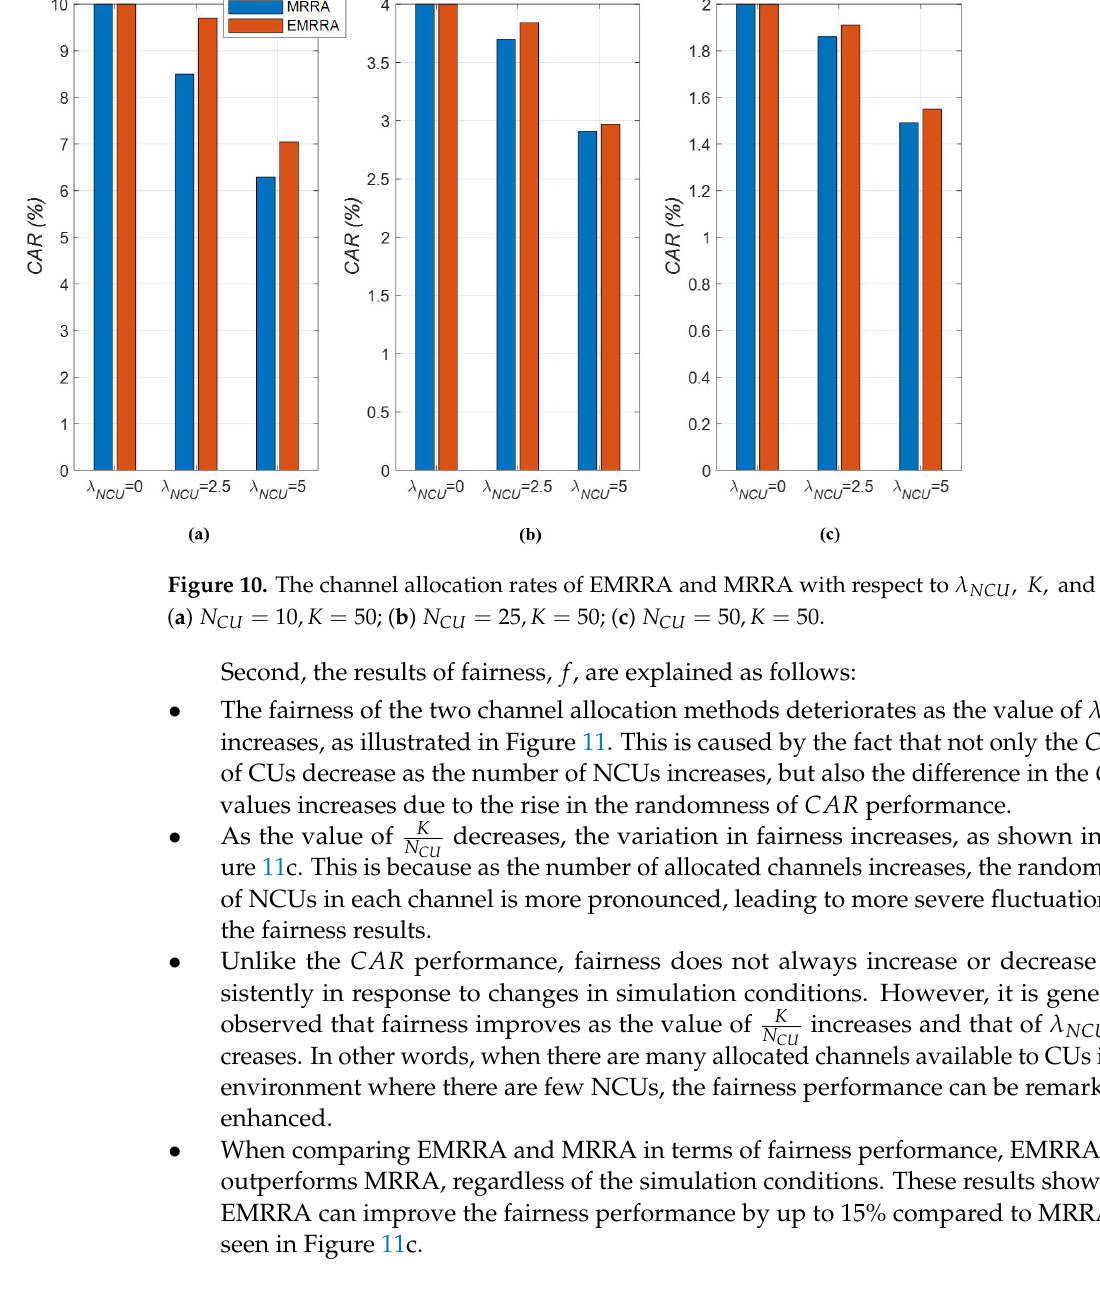
( a ) 𝜆𝜆 𝑁𝑁𝑁𝑁𝑁𝑁 , 𝐾𝐾 , and 𝑁𝑁 𝑁𝑁𝑁𝑁 :